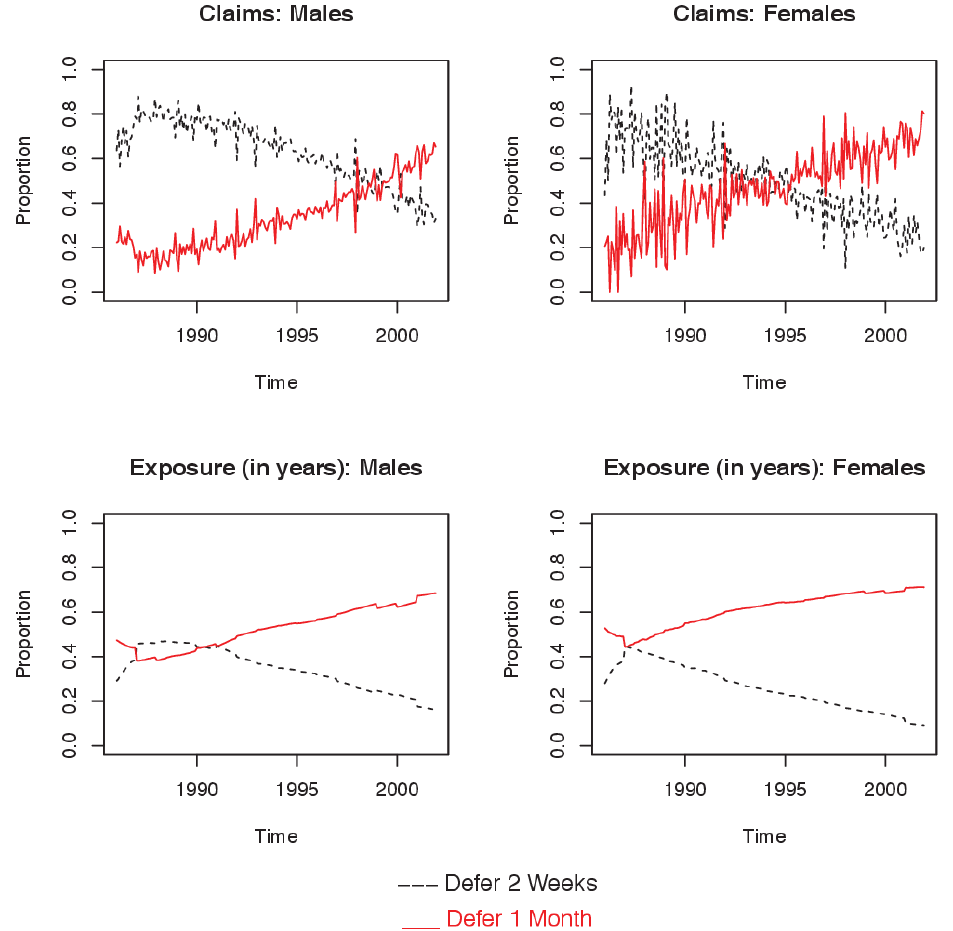
Figure A2. Insured population by deferment period (Defer): composition over time, by claims and by